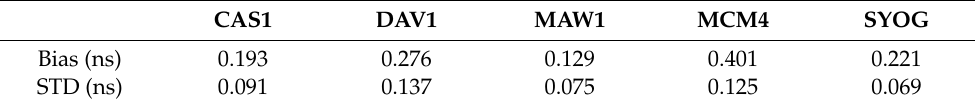
Table 3. Precision statistics of DCBs for the International GNSS Service (IGS)